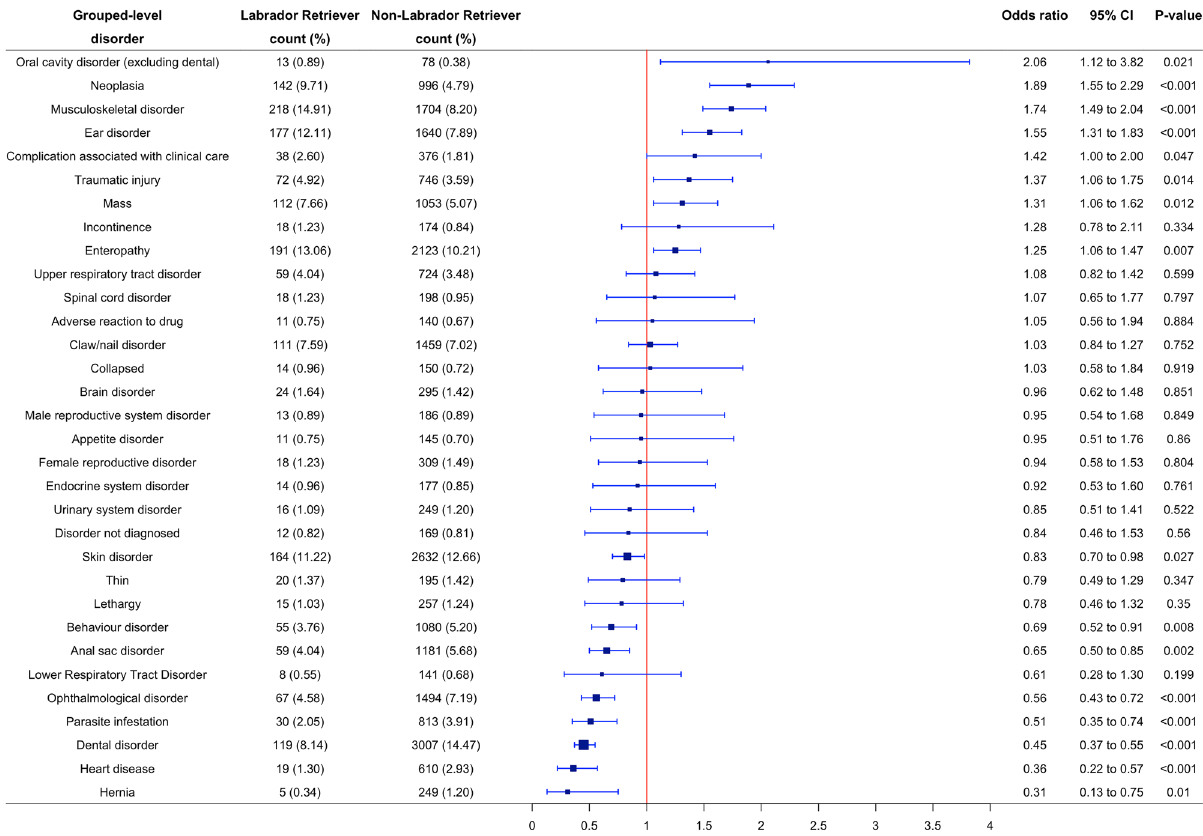
Figure 2. Forest plot of the prevalence and multivariable logistic regression odds ratios with corresponding 95% CIs (confidence intervals) for the combined list from the 30 most common disorders in Labrador Retrievers and the 30 most common disorders in non-Labrador Retrievers at a grouped-level of diagnostic precision recorded in dogs under primary veterinary care at UK practices participating in the VetCompass Programme from January 1st 2016 to December 31st, 2016. Model variables accounted for included age, sex- neuter status, at/above or below breed/sex mean bodyweight, insurance status and vet group. Grouped-level precision describes the original extracted terms mapped to a general level of diagnostic